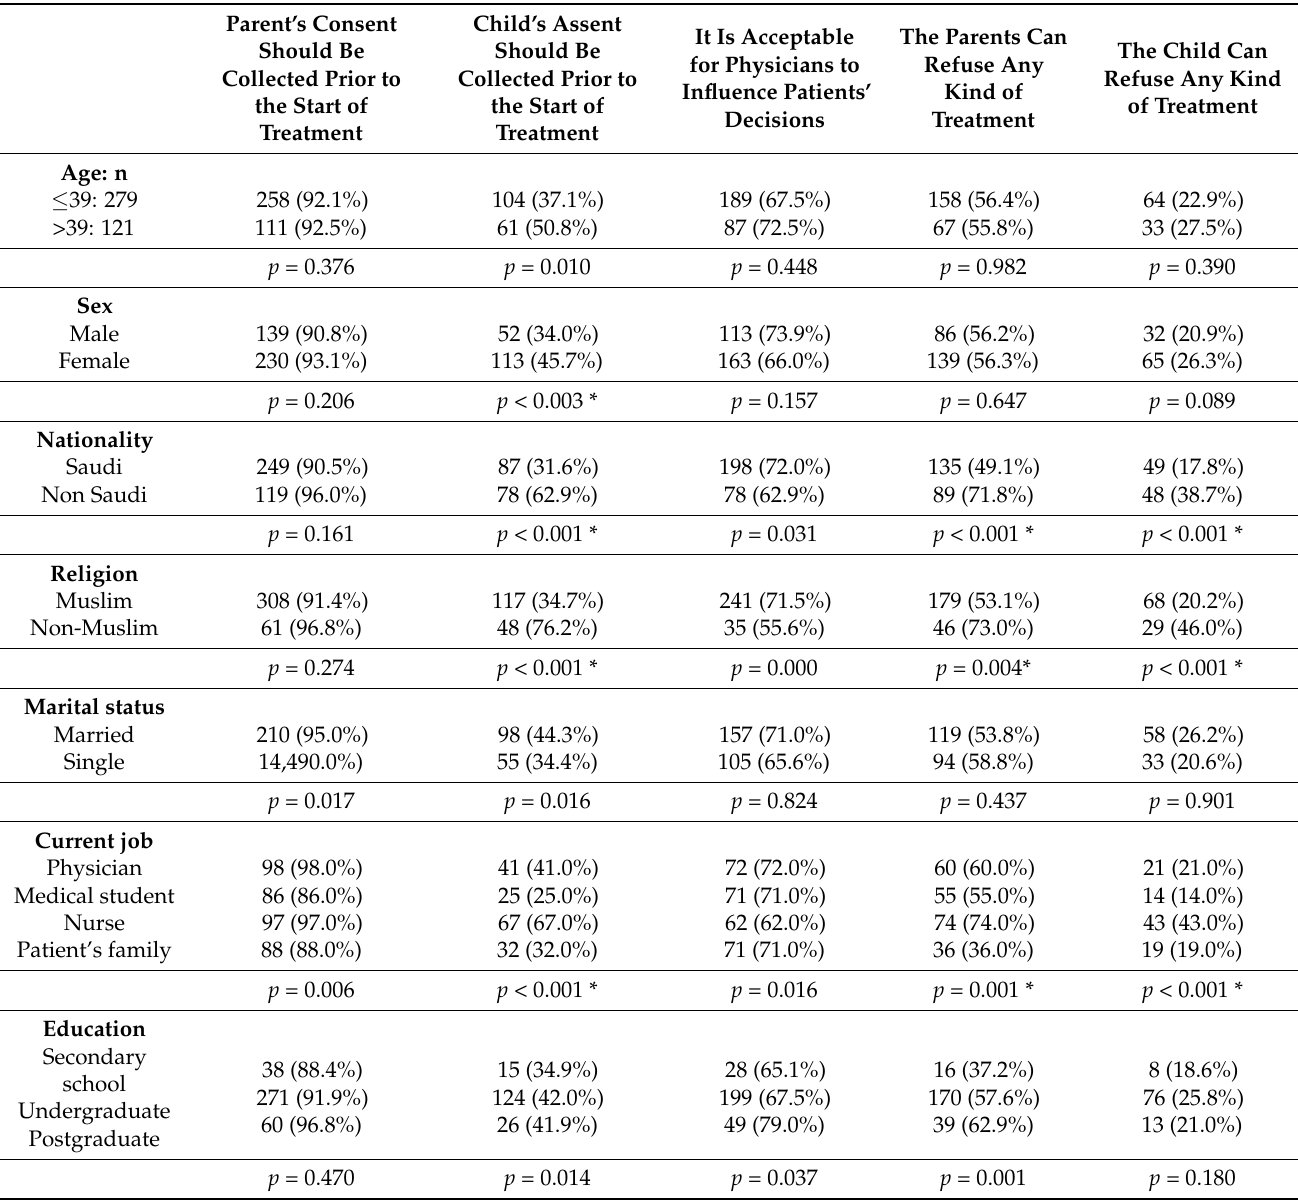
Table 5. Awareness toward parental consent and child assent across sample